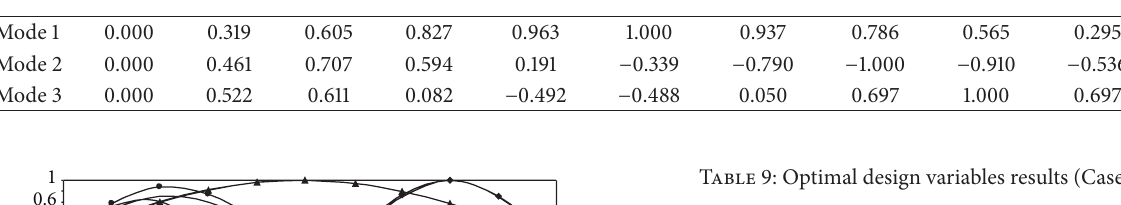
Table 8: Target mode shapes (Case 2).